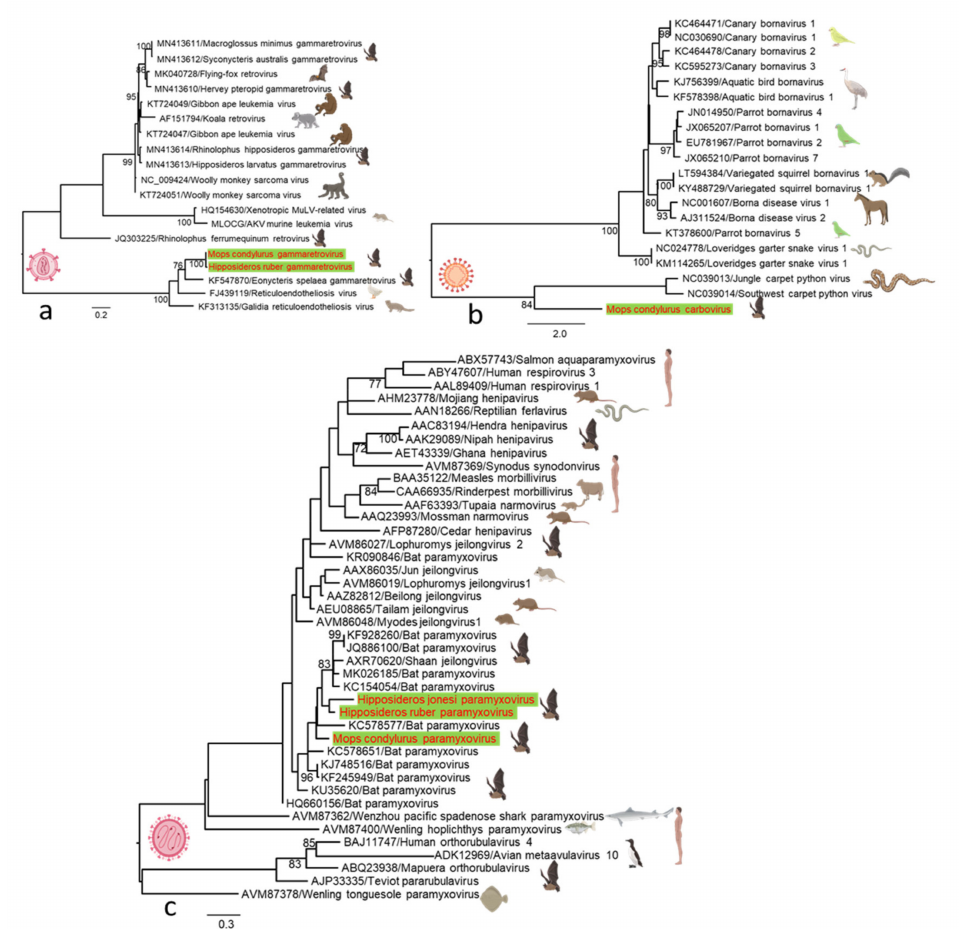
Figure 5. Maximum likelihood phylogenetic trees of viruses detected with representative members that were previously identified in other mammalian and avian hosts. ( a ) Phylogenetic analysis of representative gammaretroviruses based on the 408 nucleotide (nt) sequence of a group-specific antigen (gag) gene. ( b ) Phylogenetic analysis of representative Bornaviridae based on partial RdRp amino acid sequences. ( c ) Phylogenetic analysis based on partial RdRp amino acid sequences of the novel paramyxovirus detected in this study with other previously identified representative members of Paramyxoviridae . The phylogenetic trees are midpoint rooted and the bar scales represent either the nucleotide or amino acid substitutions per site. Bootstrap values (70%) are shown at the key nodes. The new virus species detected in this study is shown in red in each tree. The silhouettes of figures were created with